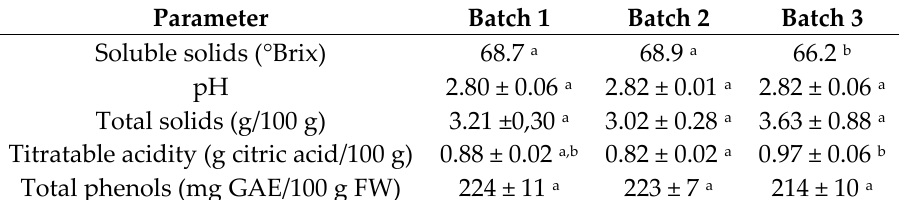
Table 3. Characteristics of the fruit marmalade of Plinia peruviana “Yvapur ũ ”.